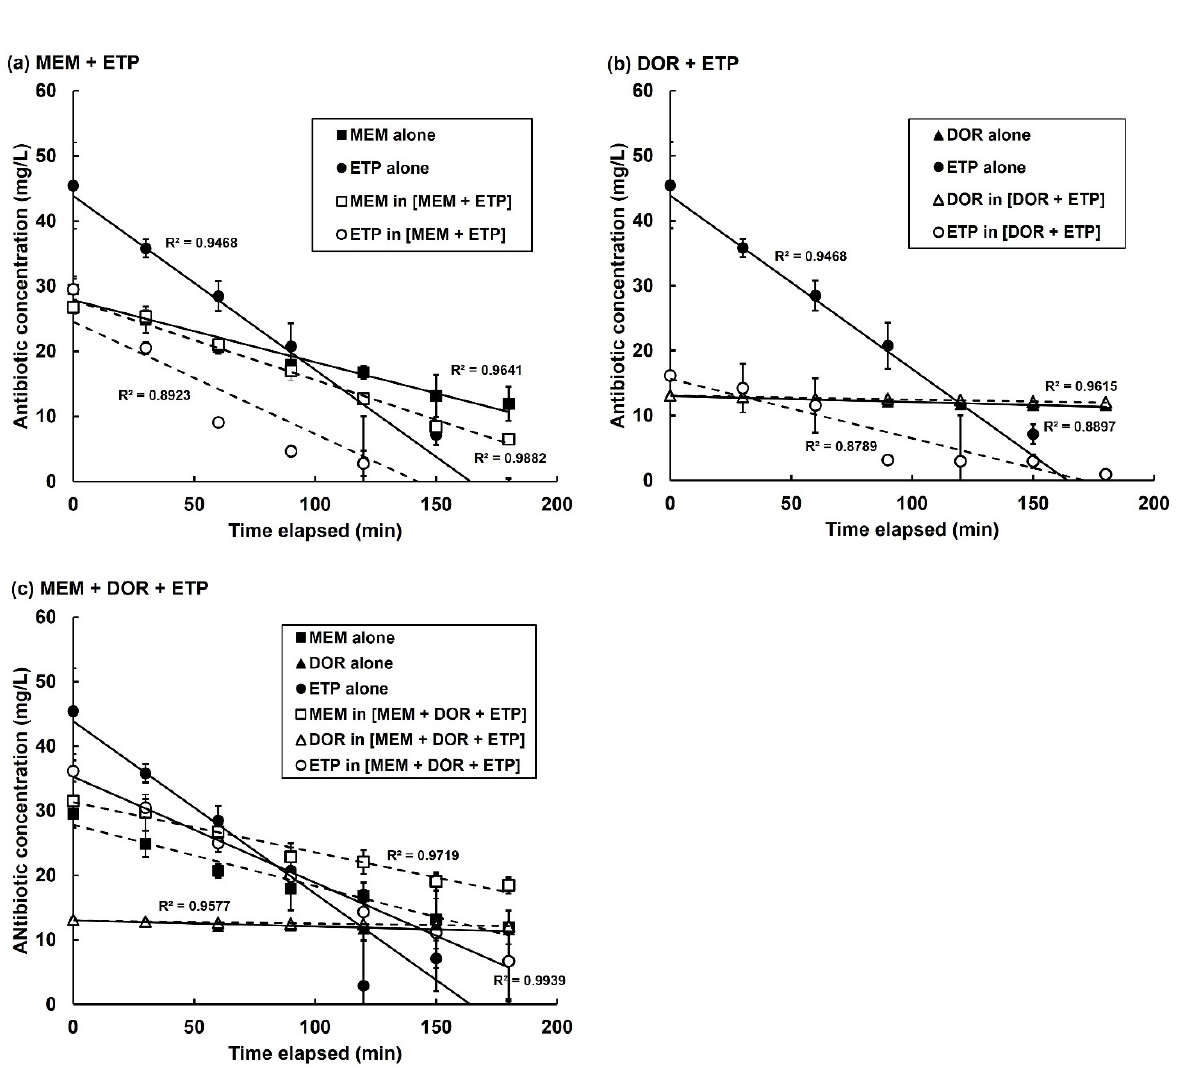
tration of MEM, DOR or ETP alone declined over the course of the experiments in a linear